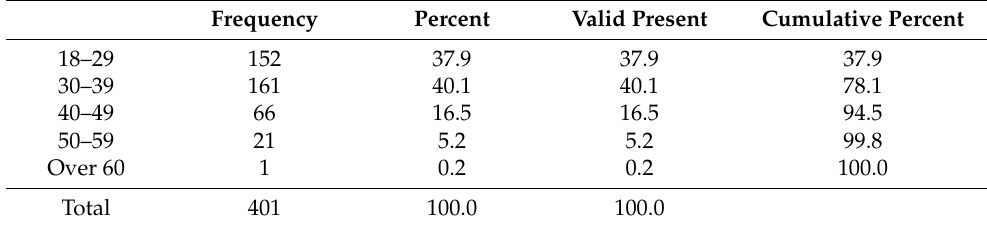
Table A2. Age of